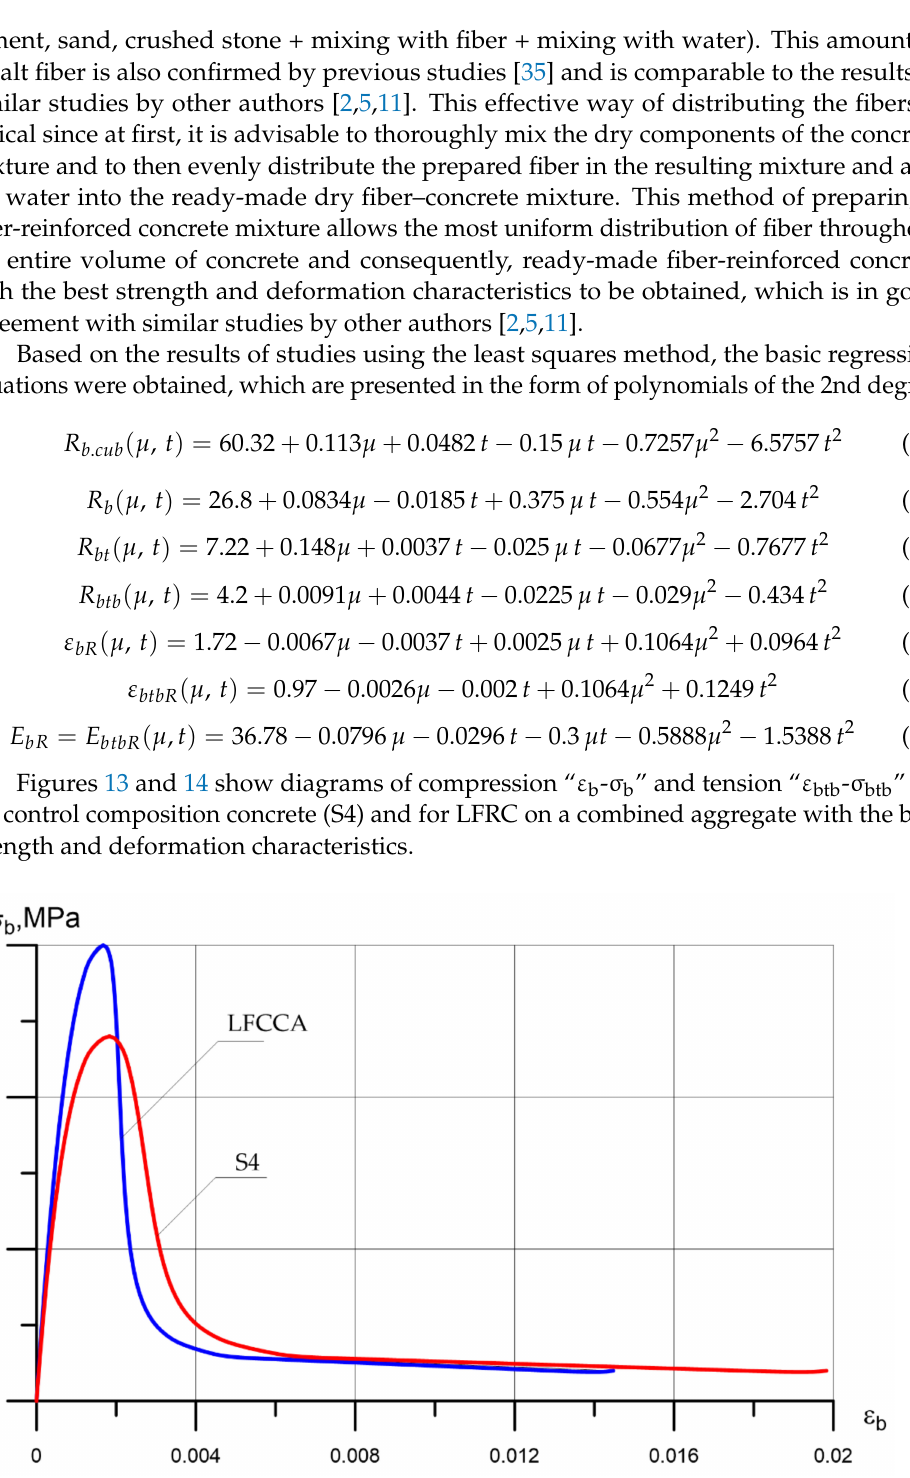
Figure 13. Diagram of the state of compressed concrete (S4—control composition; LFCCA—LFRC on a combined